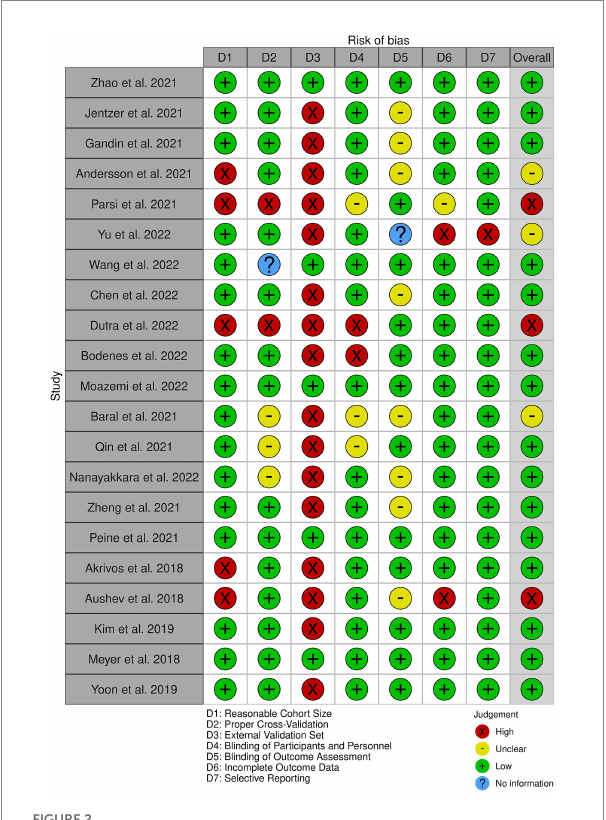
FIGURE 2 The risk of bias diagram for the selected studies. Each row corresponds to a selected study. The columns D1–D7 correspond to different risk criteria. The subjective judgements are color-coded as explained in the legend. The final column represents the overall judgement for the corresponding